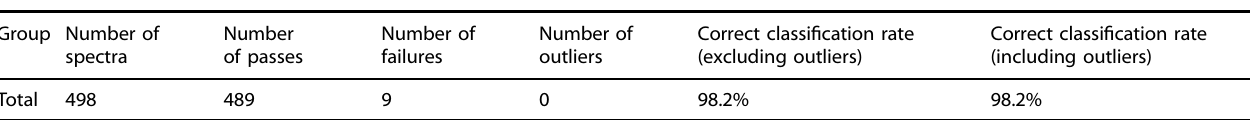
Fig. 2 Corrected meat cut models. a PCA plot for the corrected meat cut model, with clear groupings shown for neck, rump, and shin cuts. b PCA-LDA plot for the corrected meat cut model, greater separation between the three groups can be seen in comparison to Fig. Table 2. Leave-20%-Out cross-validation results for the corrected cut model.